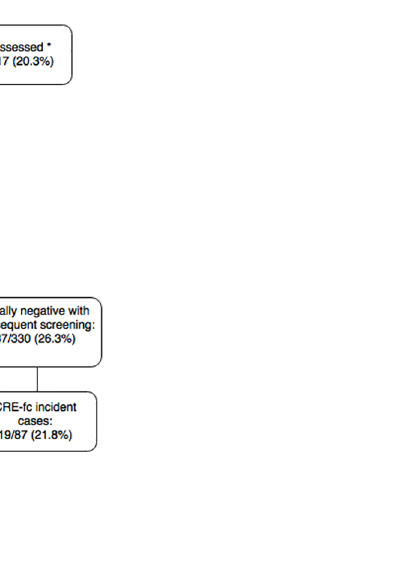
doi:10.1371/journal.pone.0139883.g001